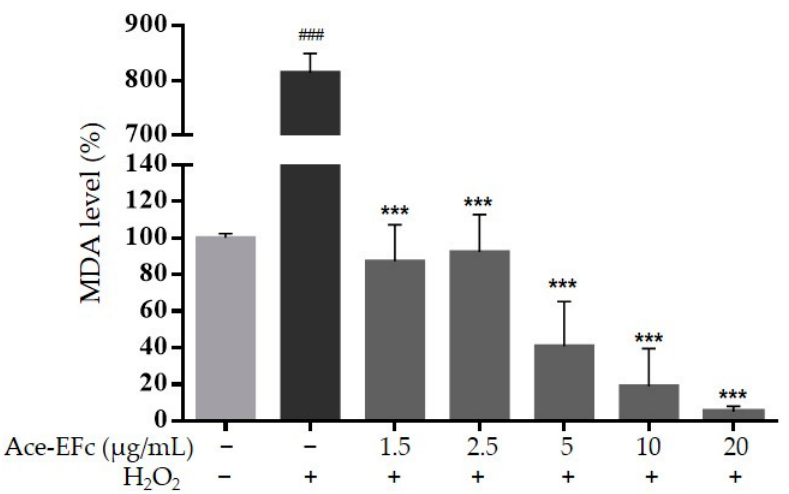
Figure 3. Protective effect of Ace-EFc against H 2 O 2 -induced lipoperoxidation. HaCaT cells were pretreated with Ace-EFc (1.25, 2.5, 5, 10, and 20 µ g/mL) for 24 h, and later, treated with 1000 µ M H 2 O 2 for 2 h. Results were expressed as the mean ± SD of three independent experiments. One- way ANOVA, Dunnett’s test: ### p < 0.001 versus no treated cells, *** p < 0.001 versus treated cells with H 2 O 2